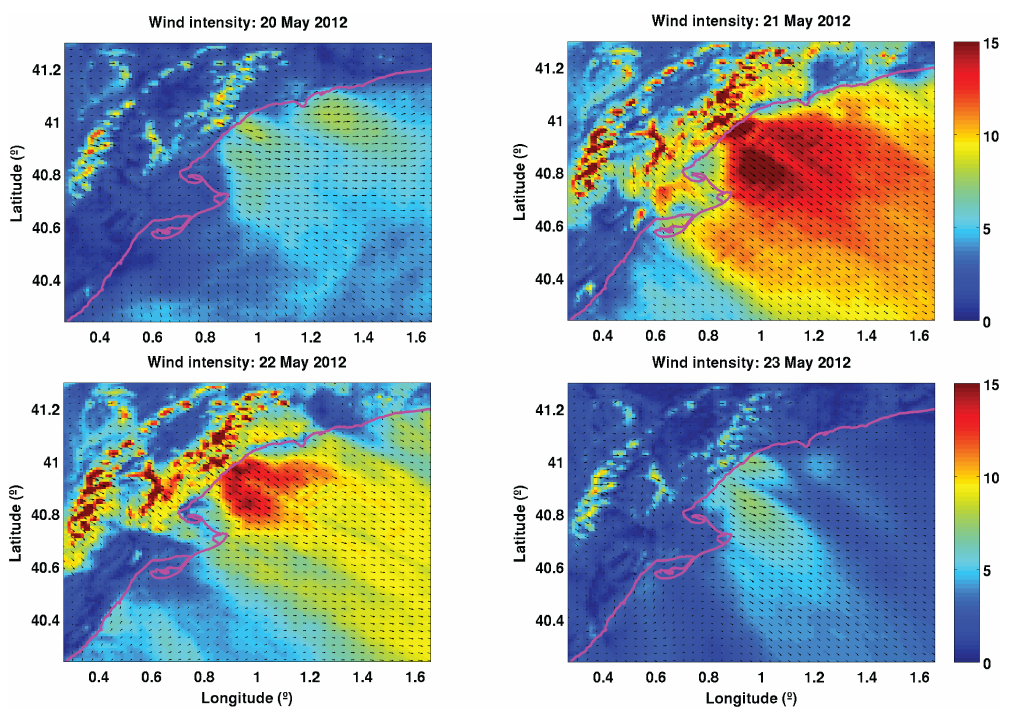
Figure 3. Sequence of the wind jet intensity on 4 days for a wind jet event in the domain of the Catalan coast. The quiver is shown for each of the three points. Results obtained for COAWST at mesh M3 are plotted.